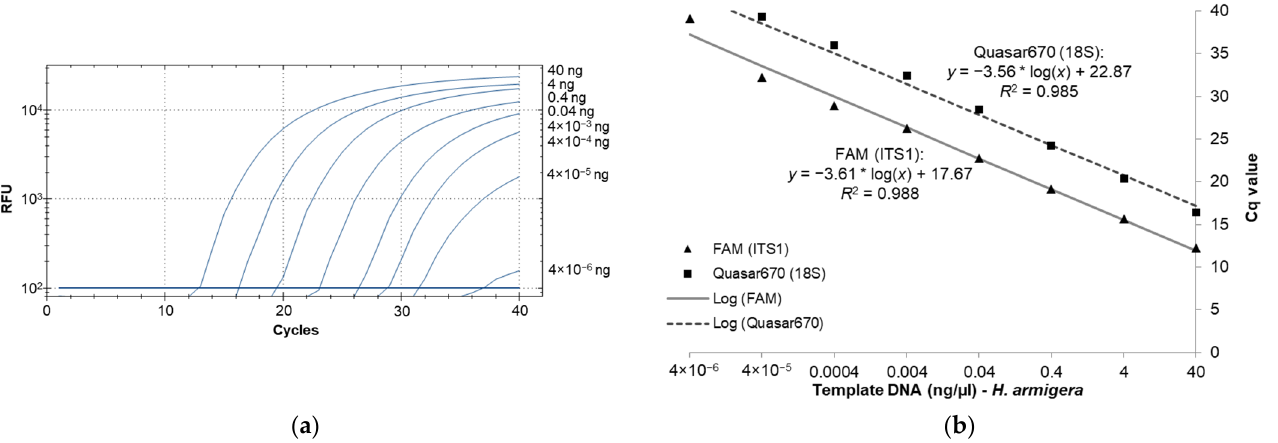
Figure 1. The diagnostic probe can detect the presence of H. armigera DNA across a wide dynamic range. ( a ) Amplification plot generated by serial dilution of H. armigera template DNA for the ITS1 diagnostic probes; ( b ) serial dilutions of template DNA for 6 H. armigera individuals with a standard. *: multiplication sign.